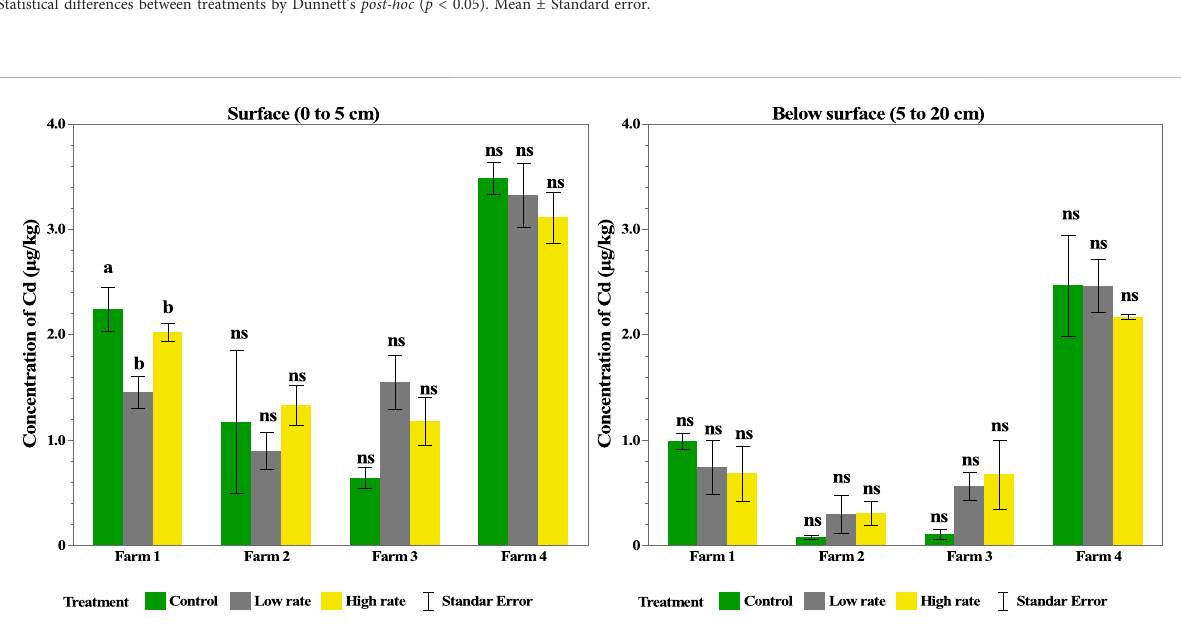
FIGURE 2 Cadmium concentrations bound to the KNO 3 /H 2 O fraction in the soil in fl uenced by the compost applied at the surface and below-surface soil depth. Letters on the top of the bar indicate the statistical differences between treatments by using Dunnett ’ s post-hoc ( p < 0.05). Ns: no statistical